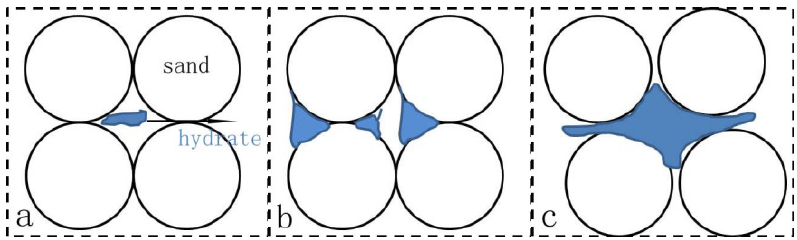
Figure 6. Schematic diagram of different type of hydrate habits. ( a ) pore filling; ( b ) cementation; ( c ) load bearing.